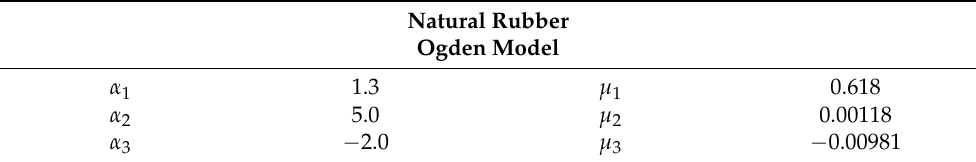
Table 3. Modelling parameters for the natural rubber,